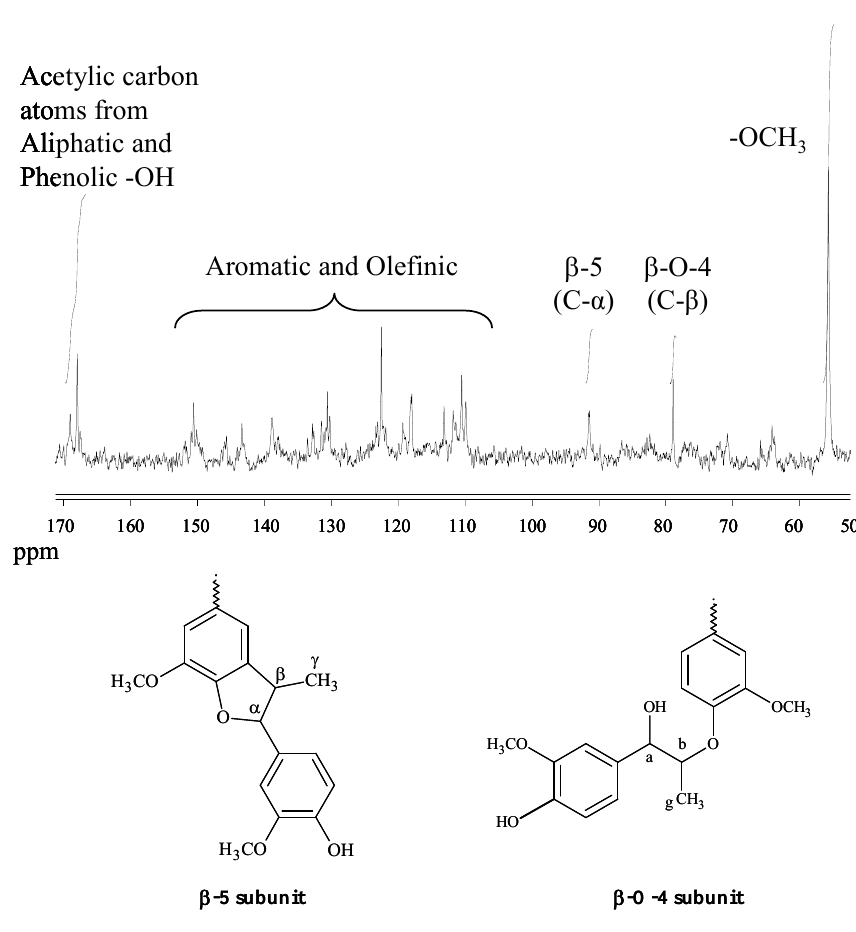
Figure 3. 13 C-NMR spectrum of the acetylated isoeugenol DHP and chemical structure of principal intermonomeric linkages detected ( β -5, β - O